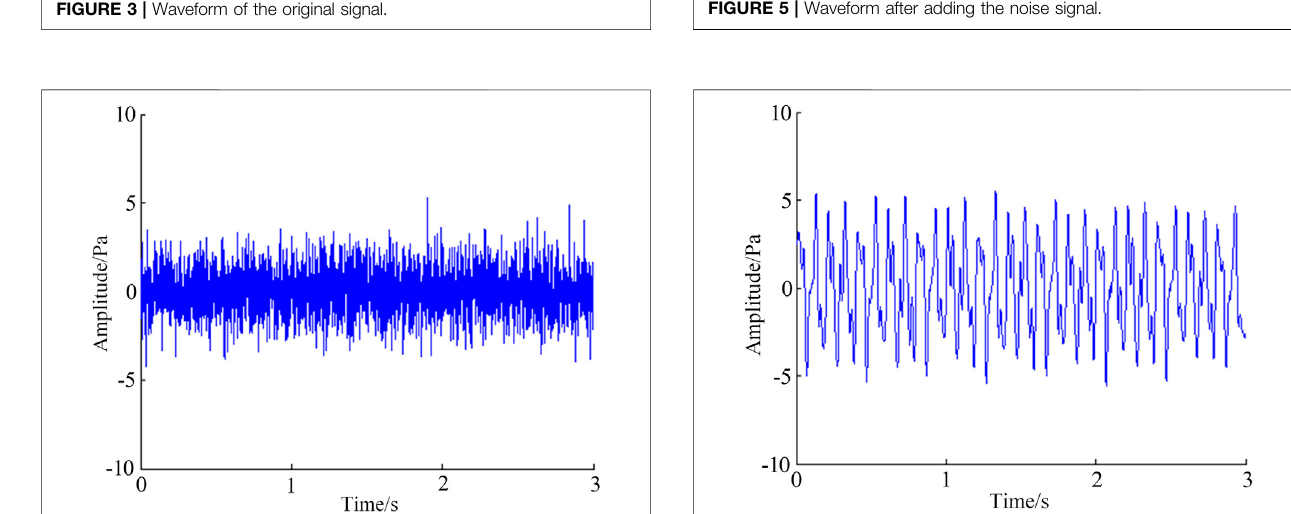
FIGURE 5 | Waveform after adding the noise signal.